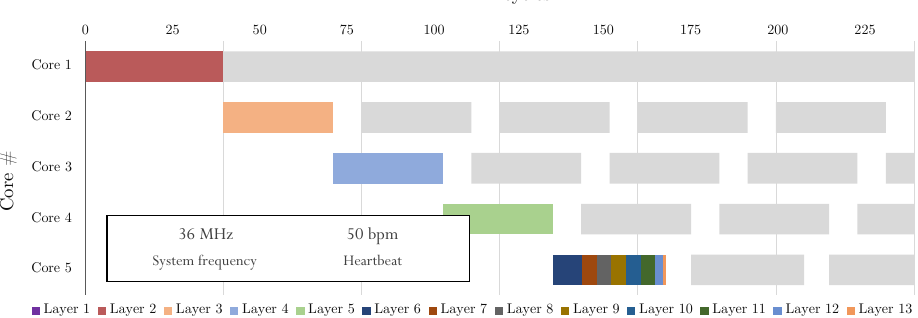
Figure 12. The baseline setup for the selected use case on